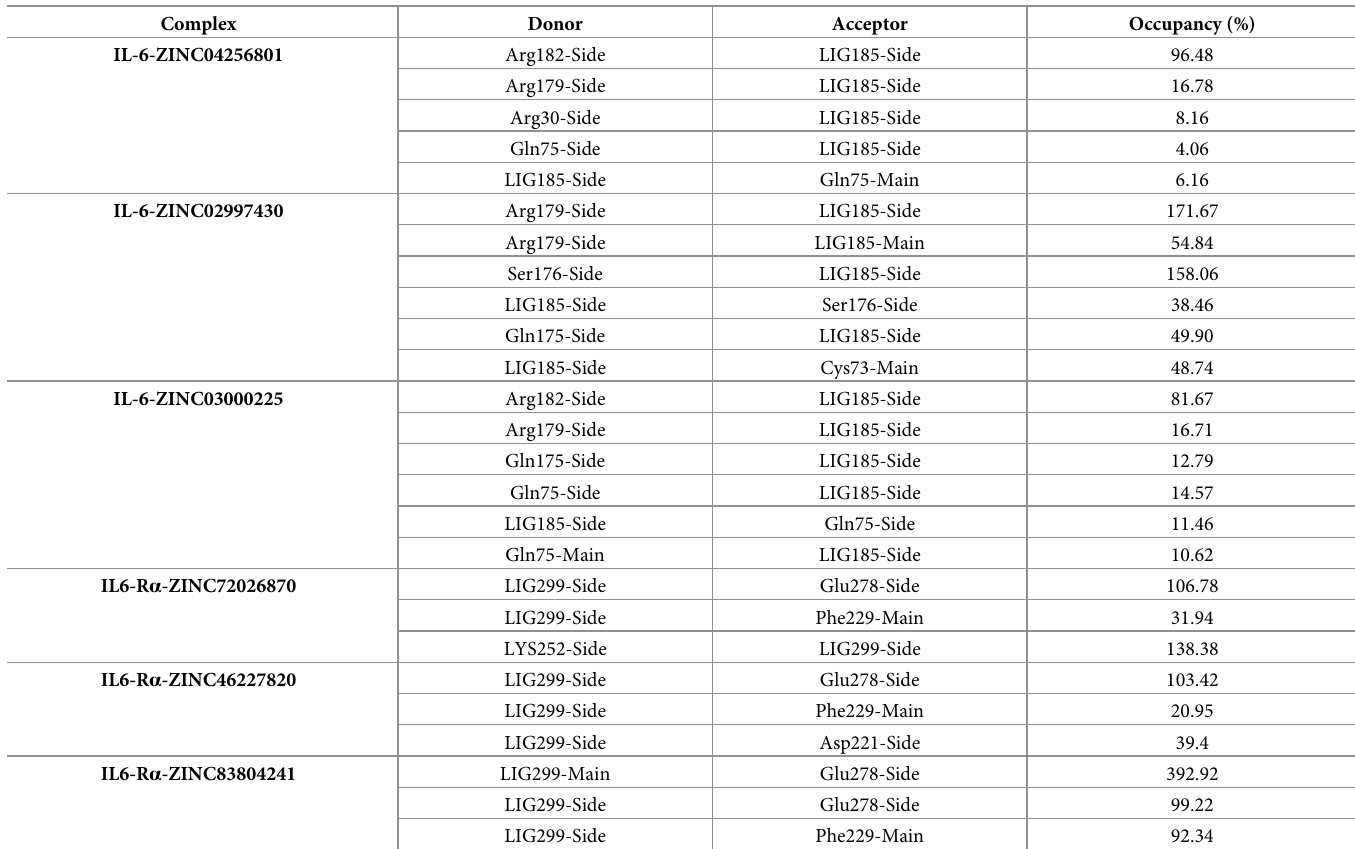
Table 4. Hydrogen bond occupancy of 6 top hit ligands from data of the 50ns MDs trajectories.